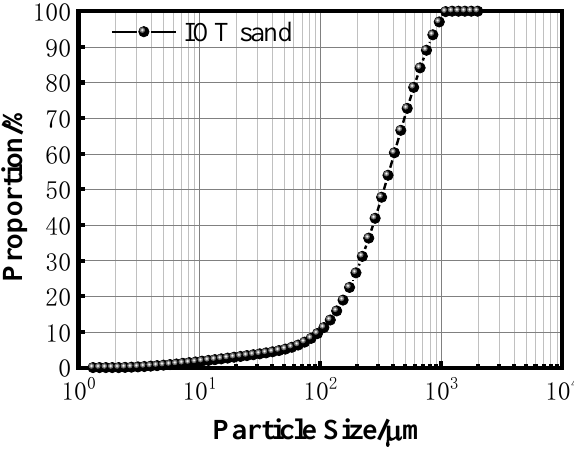
Figure 6. Particle size curve of IOT sand.